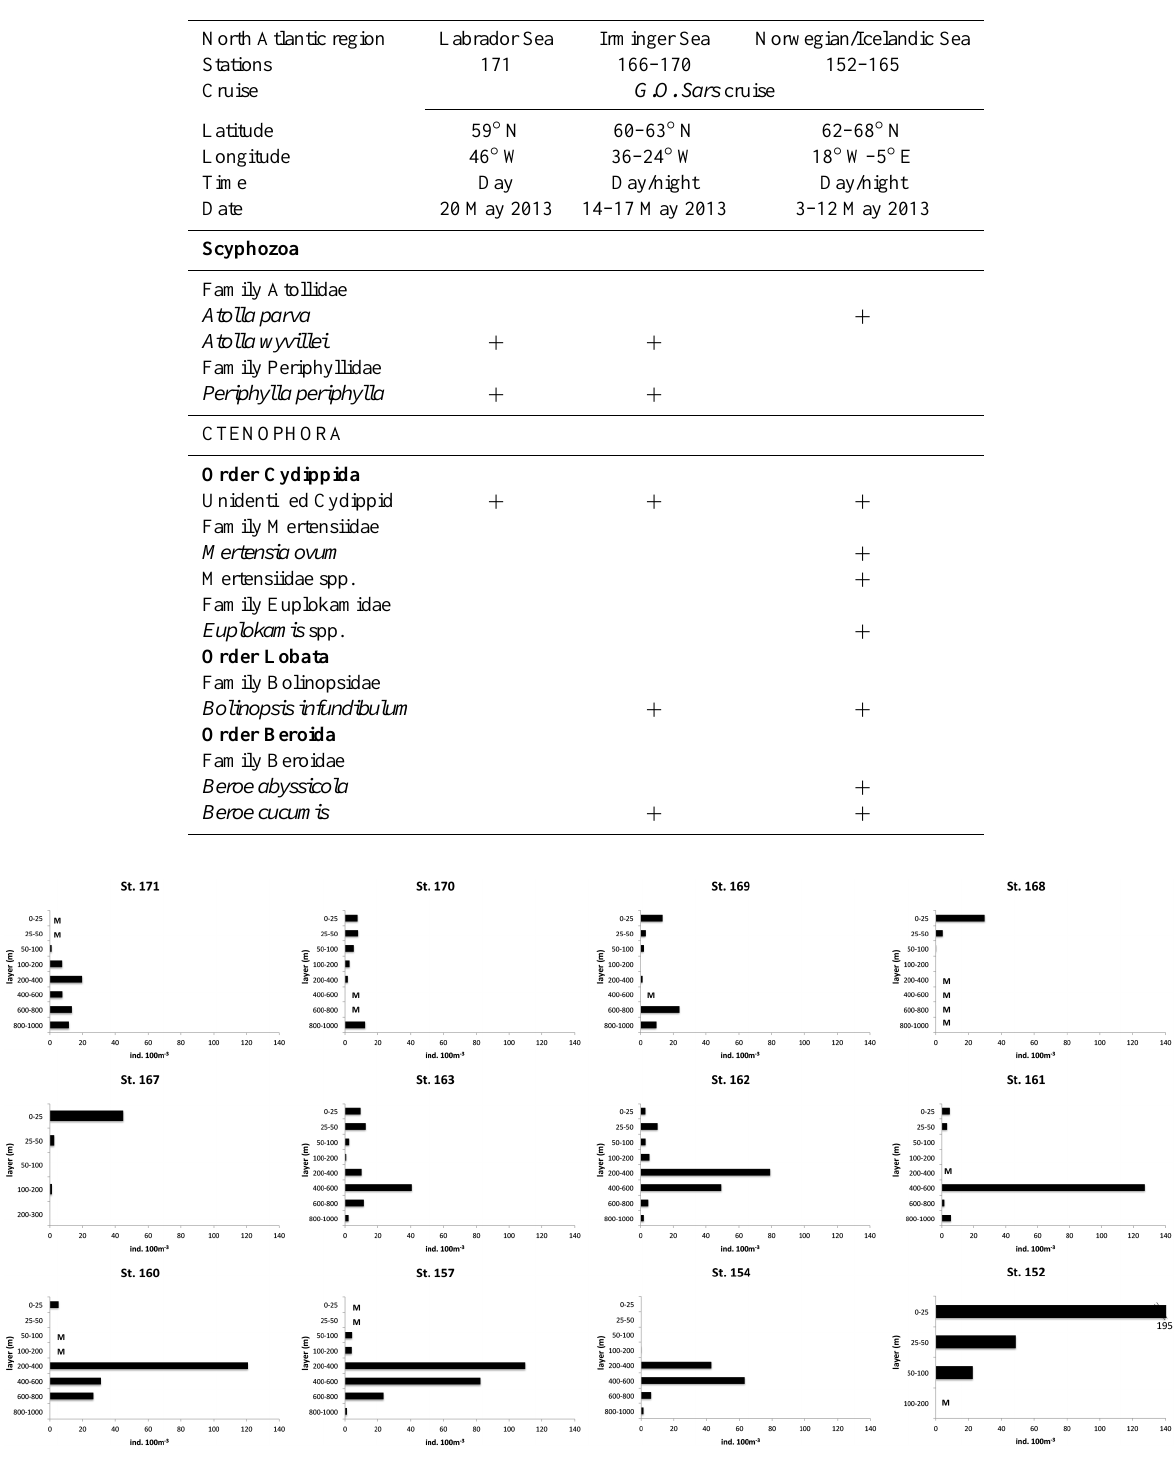
Figure 4. MOCNESS data set. Abundance of jellyfish at different depths in the 0–1000m layer. Please note the shallower depths in stations 152 and 167. Station 155 is not shown. M: samples preserved in formalin, not yet analysed.